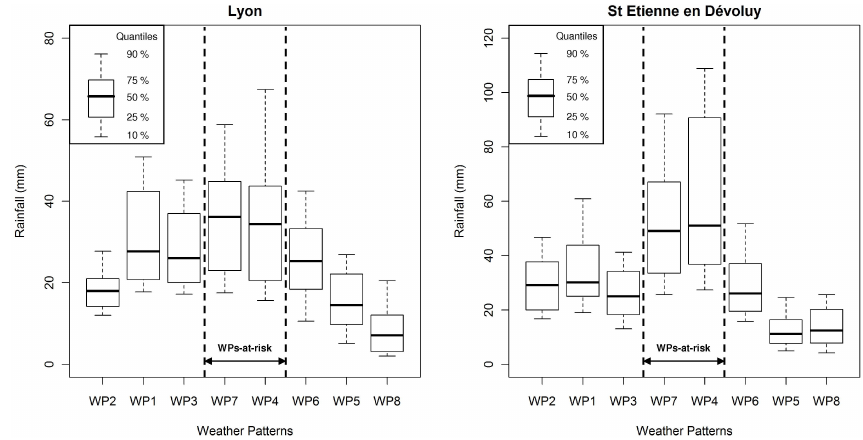
Fig. 5. Box plot of the annual maxima for each weather pattern at Lyon rain gauge (left) and St Etienne en D´evouly (right) (records for the period 1953–2005). Dashed lines and double arrow highlight the “WPs-at-risk” (WP associated to highest rainfall quantiles): WP 7 and WP